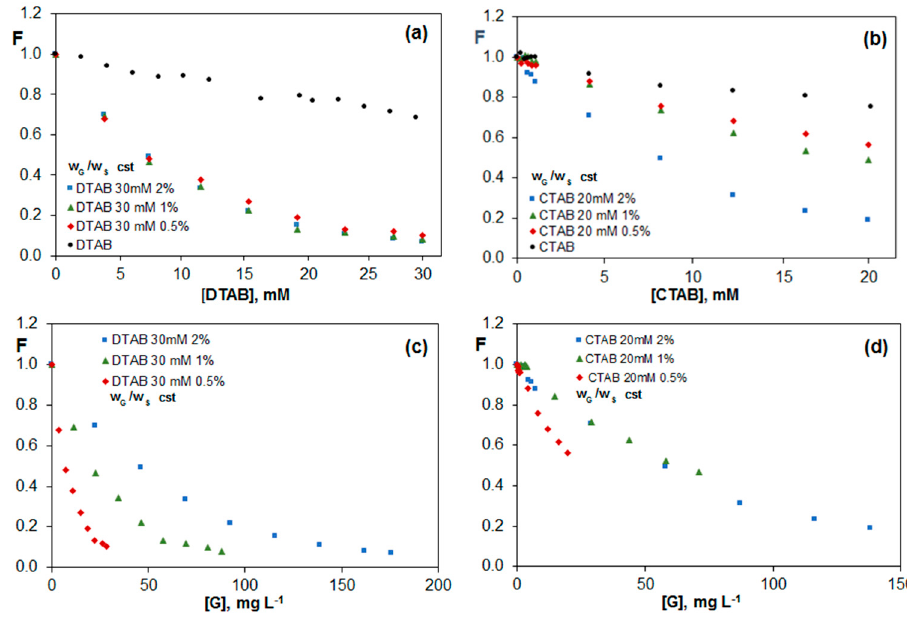
Figure 7. Fluorescence of vitamin B 2 (F) vs. surfactant ( a , b ) or graphene ( c , d ) concentration for G dispersions in 30 mM DTAB ( a , c ) and 20 mM CTAB ( b , d ), for solutions with a constant G/surfactant weight ratio.